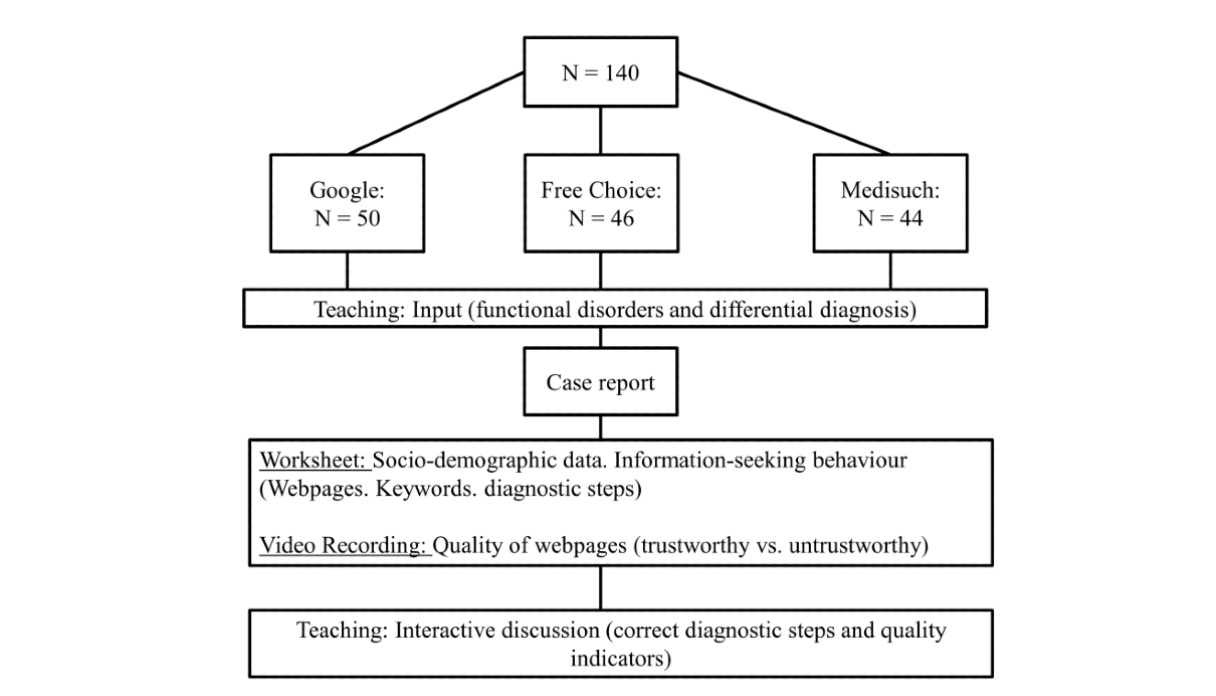
Figure 1. Process of study including teaching and